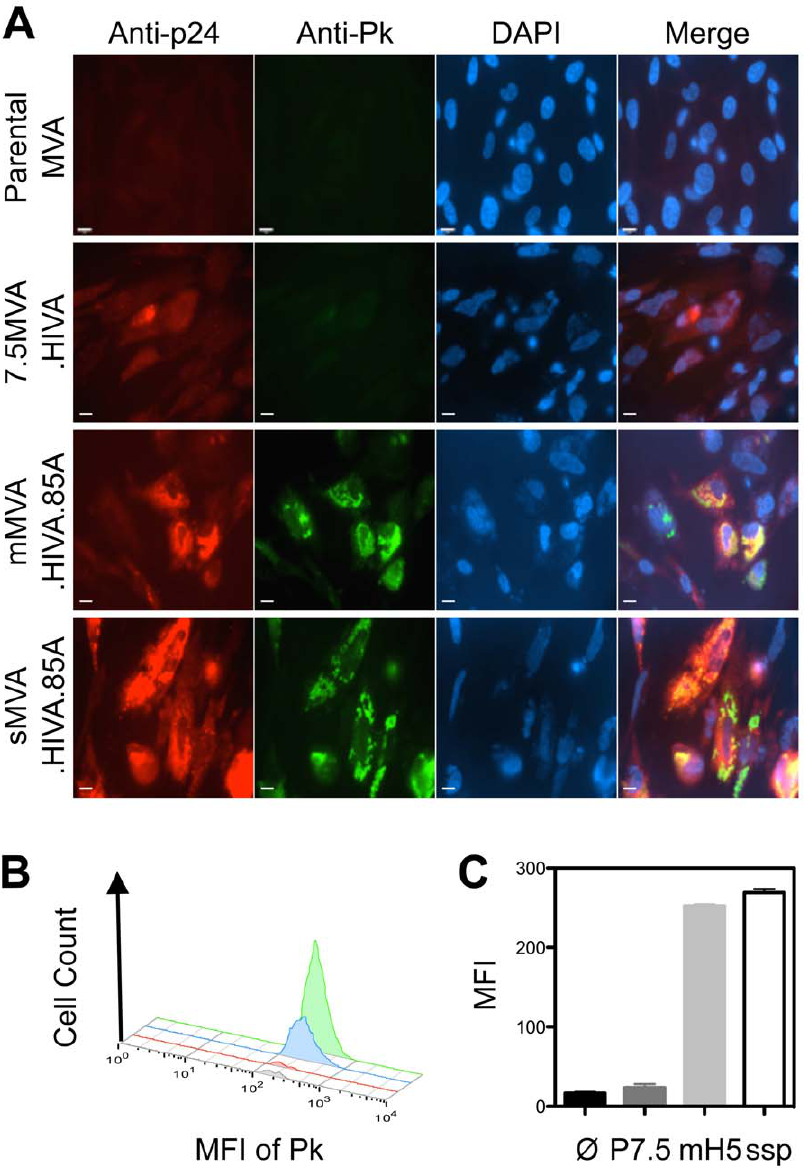
Figure 2. Protein expression from recombinant MVAs in CEF cells. CEF cells were infected with indicated viruses at MOI 1 for 16 h. ( A ) Cell were stained either for Gag p24 or Pk tag (on HIVA and Ag85A) expression as shown above and analyzed under fluorescent microscope. Also, the relative levels of protein expression were assessed using flow cytometry and shown either as a ( B ) histogram for parental MVA (black), 7.5MVA.HIVA (red), mMVA.HIVA.85A (blue) or sMVA.HIVA.85A (green) viruses or ( C ) expressed as mean fluorescent intensity (MFI) 6 SD ( C ). The figure shows representative data of three independent experiments.